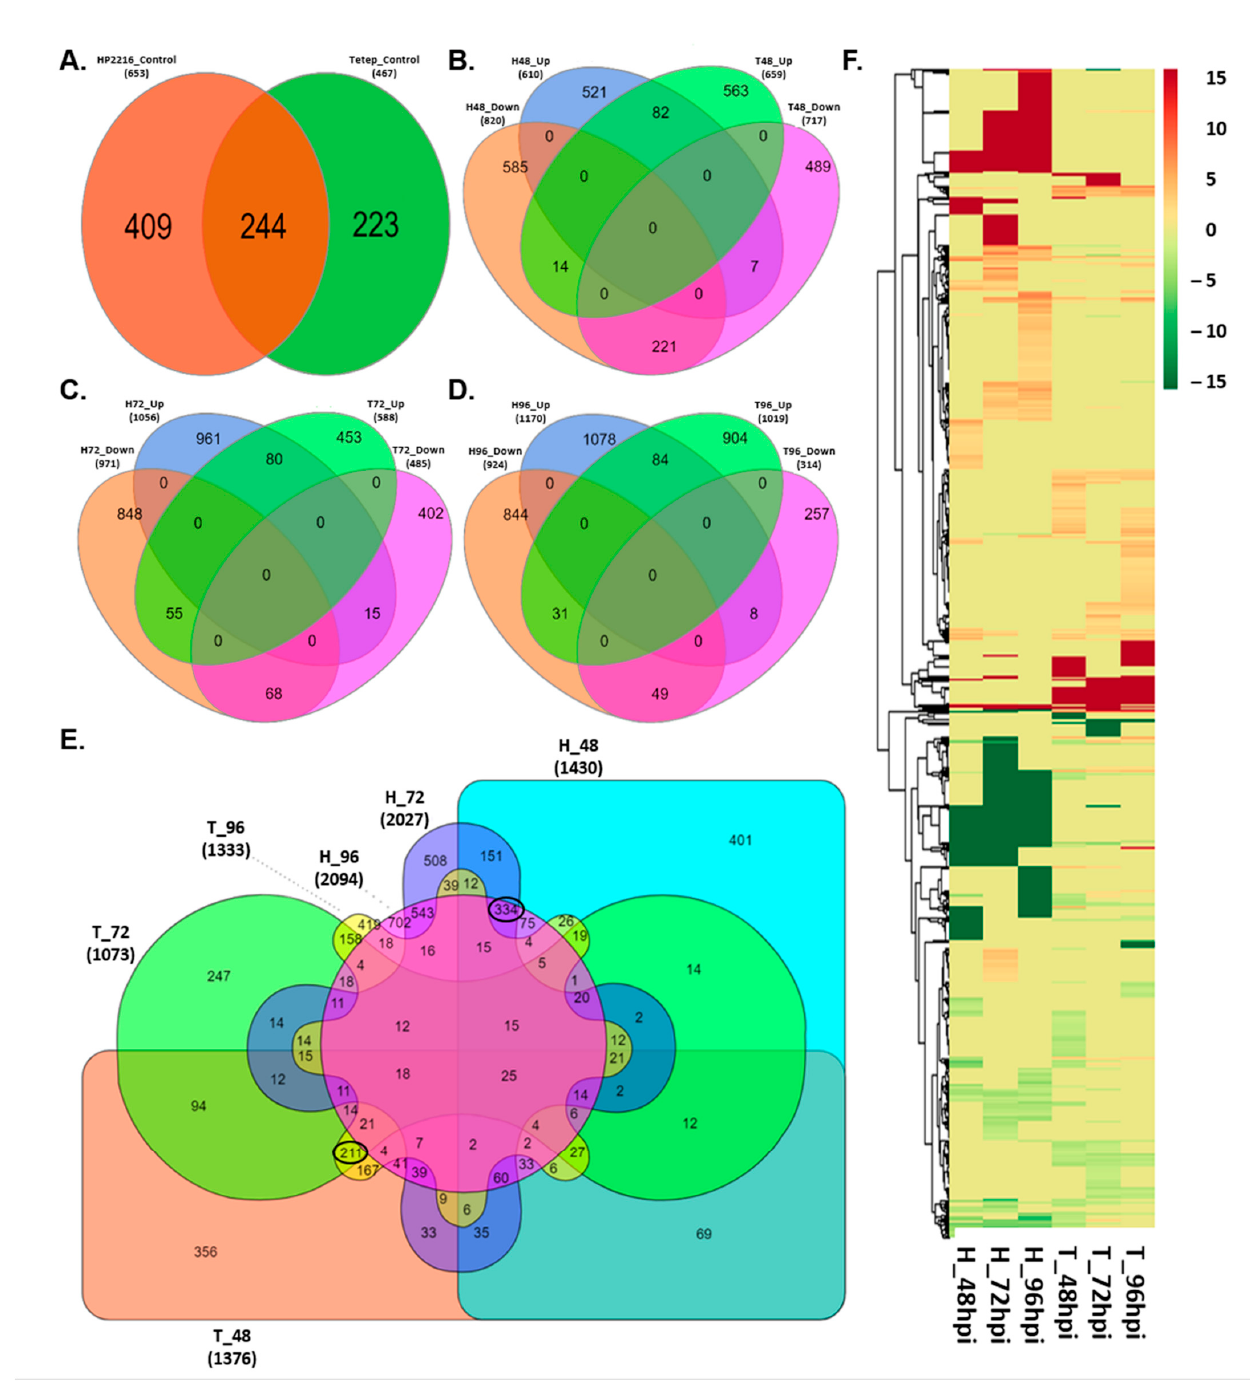
Figure 2. Differentially expressed genes in Tetep and HP2216. Study of plant-pathogen interaction using Venn and expression profiling in Tetep and HP2216 rice, infected with M. oryzae , at different time intervals. ( A ) Total expressed loci common and unique between Tetep and HP2216 in mock samples without infection (control). ( B ) Significant (FDR adjusted p ≤ 0.01) DELs (log2 fold change ≥ 2) common and unique in Tetep and HP2216 at 48 hpi. ( C ) Significant DELs common and unique in Tetep and HP2216 at 72 hpi. ( D ) Significant DELs common and unique in Tetep and HP2216 at 96 hpi. ( E ) Significant DELs common and unique between Tetep and HP2216 at all three-time intervals. ( F ) Heat map of significant (FDR adjusted p ≤ 0.05 & log2 fold change ≥ 2) DELs of Tetep and their respective log2 fold change in HP2216. Red represents up-regulated loci and green represents down-regulated loci.